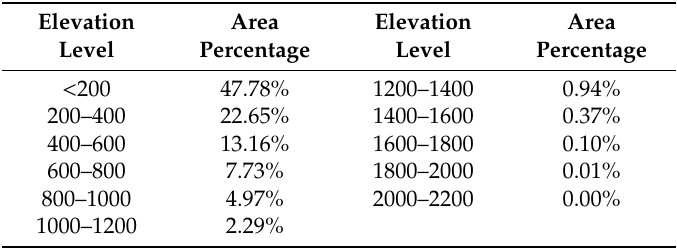
Table 4. The area percentages of 11 elevation levels.